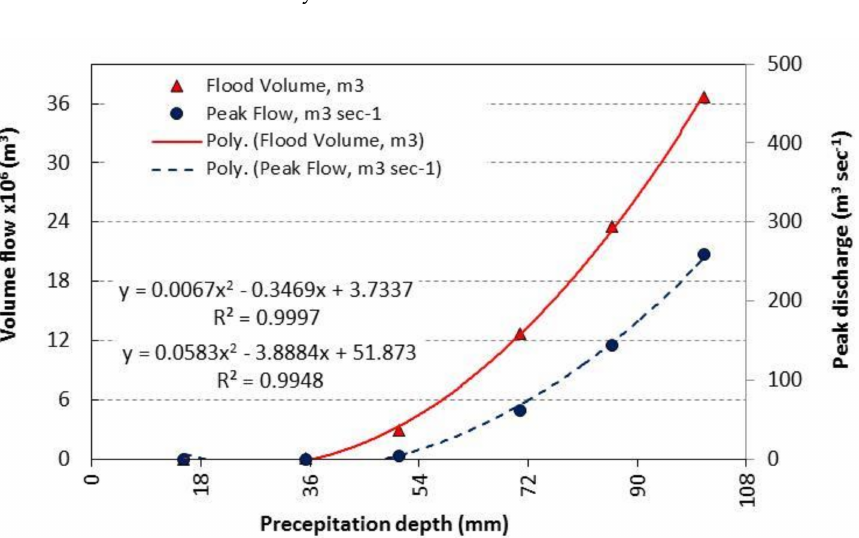
Figure 6. Relation between the projection precipitation depths and watershed